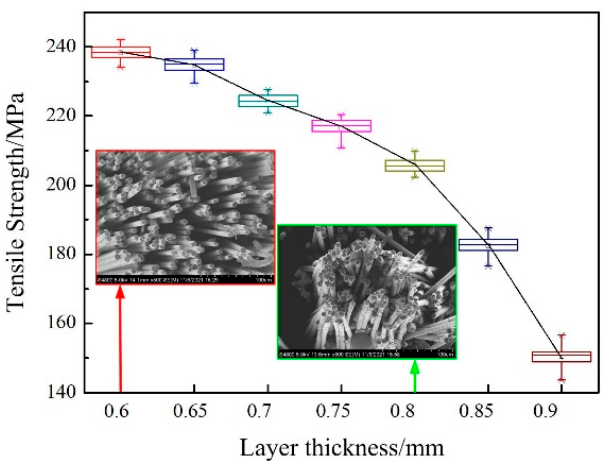
Figure 11. The test results for the tensile properties of the three-layer entities prepared at different printing layer thicknesses and the microstructures of carbon fiber distribution at the fracture point of the sample. The red arrow points to the microstructure of the sample formed when the layer thickness is 0.6 mm. The green arrow points to the microstructure of the sample formed when the layer thickness is 0.8 mm.